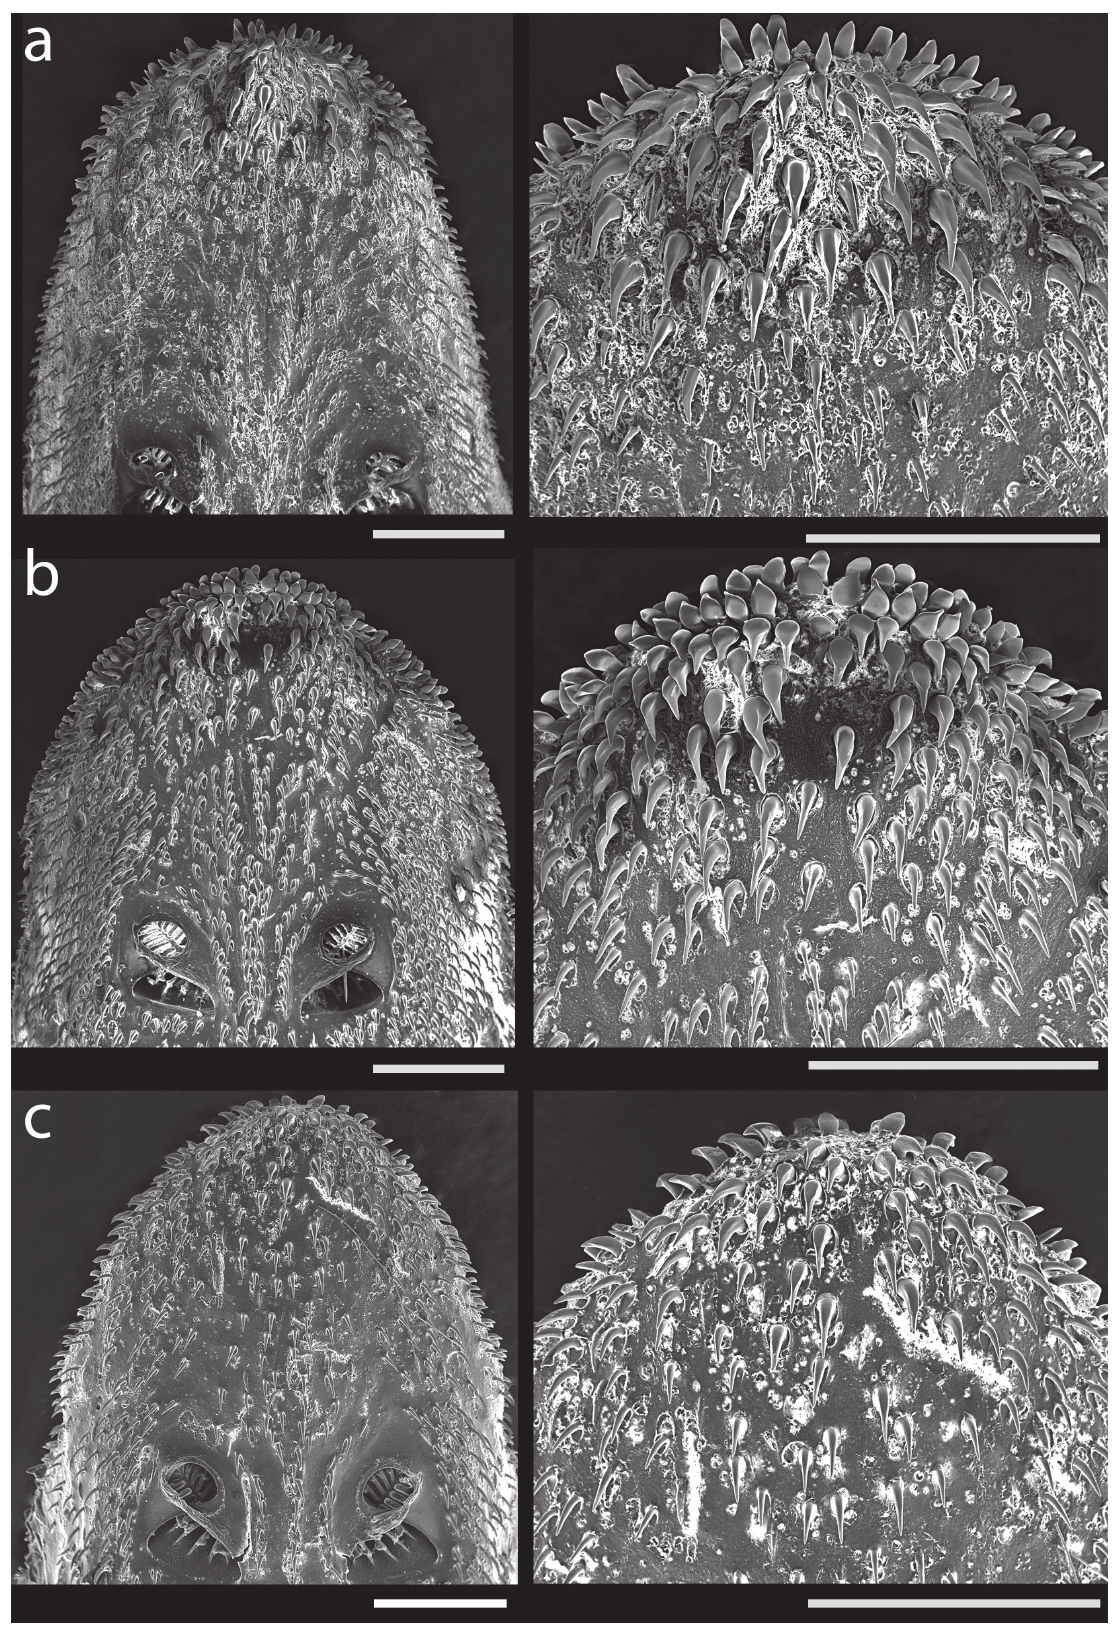
Fig. 2. Field Emission Scanning Electron Microscopy (FESEM) of snout tip showing hypertrophied odontodes of species of Curculionichthys . a. C . hera , paratype, MCP 51571; b . C . itaim , MCP 51569; and c . C. insperatus , MCP 47070. Scale bars = 1